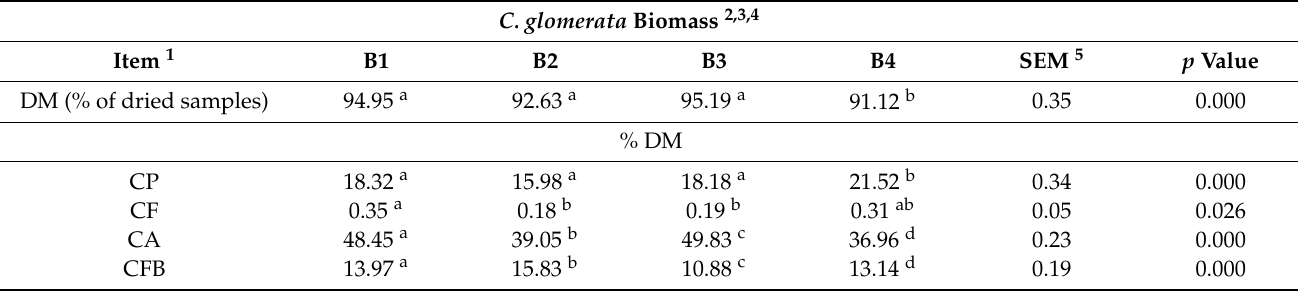
Table 3. Chemical composition of C. glomerata biomass from different rivers in